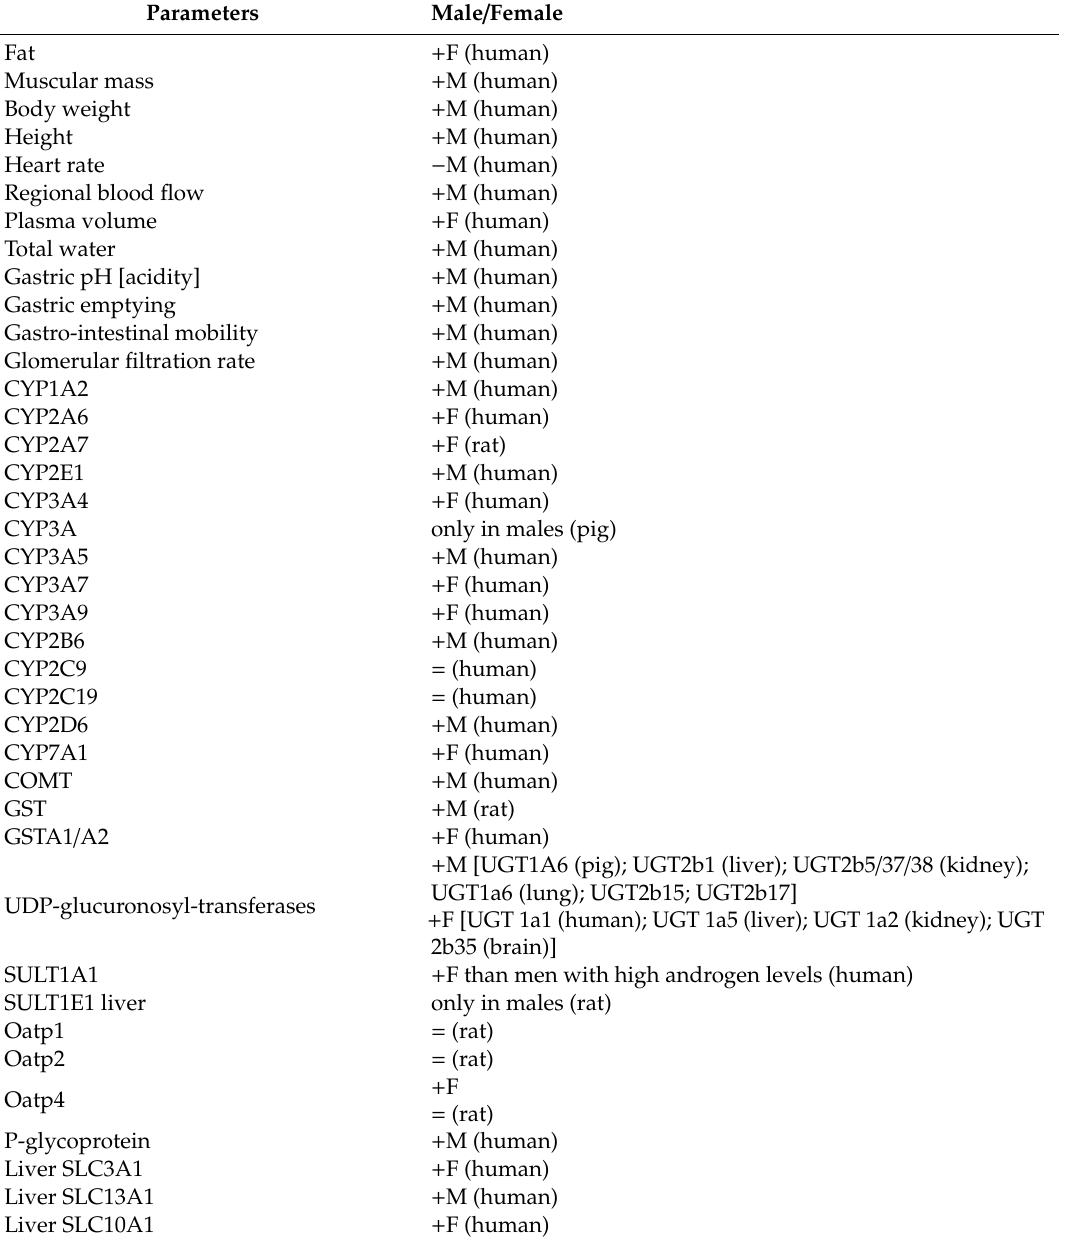
Table 1. Some sex–gender di ff erences involved in